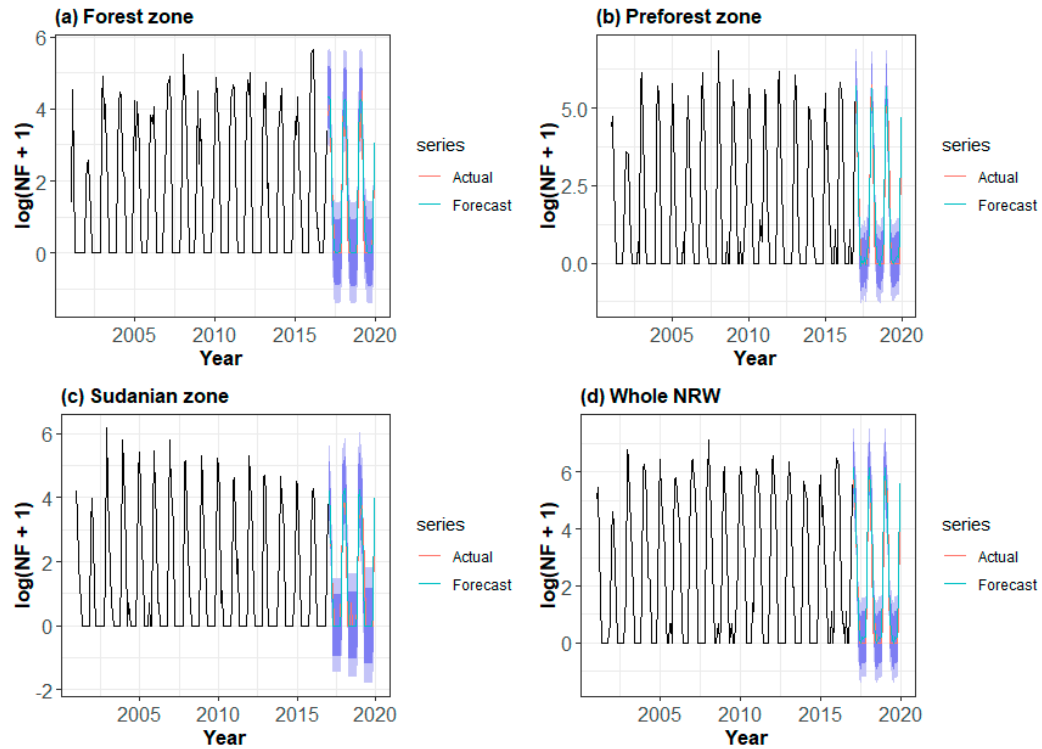
Figure 5. Forecasts of the number of wildfires in the ( a ) forest zone, ( b ) pre-forest zone, ( c ) Sudanian zone, and ( d ) whole NRW using the training